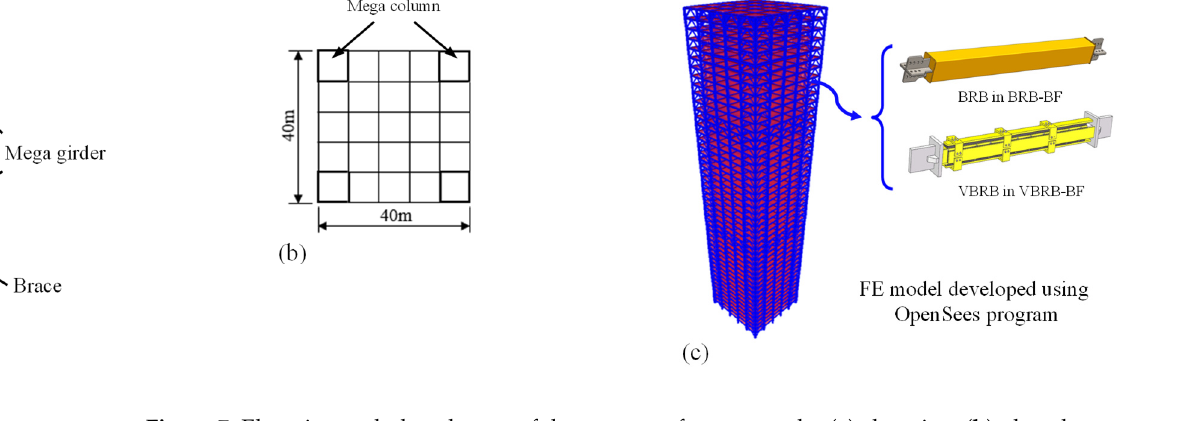
Figure 7. Elevation and plane layout of the structure for case study: ( a ) elevation; ( b ) plane layout; and ( c ) analytical model for BRB-BF/VBRB-BF. Table 4. Sectional information of the mega braced